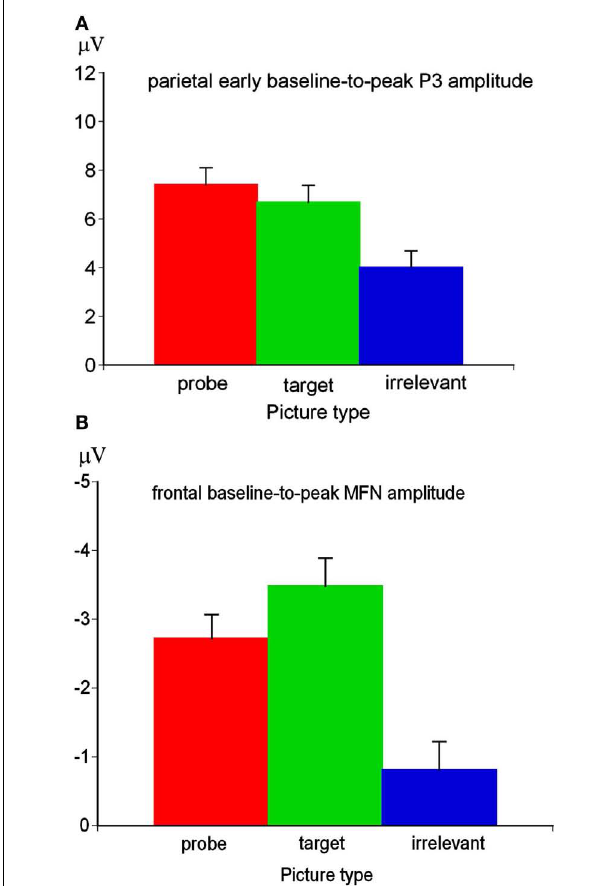
FIGURE 4 | Picture type main effect for the early parietal baseline-to-peak P3 amplitude (A) and picture type main effect of the frontal baseline-to-peak MFN amplitude (B).